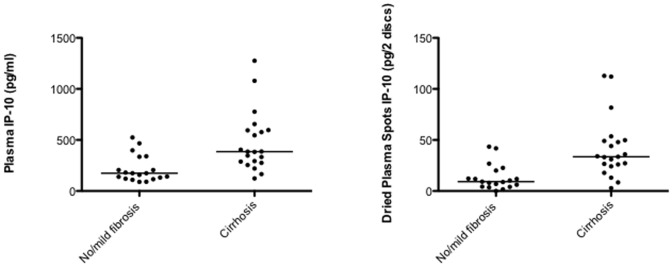
IP-10 measurements.IP-10 measured in plasma (left) and dried plasma spots (right) from 19 patients with chronic hepatitis C infection and no/mild liver fibrosis and 21 patients with liver cirrhosis. Line denote median. There was a significant difference between the groups in both plasma and dried plasma spots, p<0.0004.